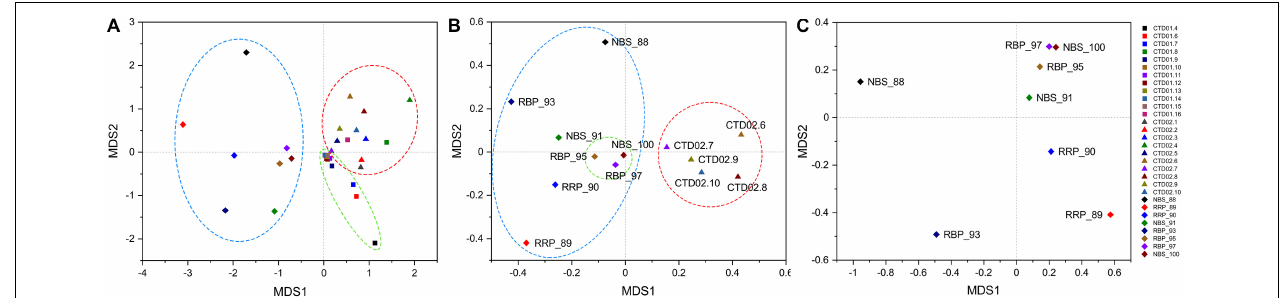
FIGURE 3 | NMDS statistical analysis of bacterial and archaeal communities. (A) Bacterial results from all samples. Diamond: samples collected by HOV Jiaolong. Square: samples of CTD01 station. Triangle: samples of CTD02 water column including three non-buoyant plumes. (B) Bacterial results of those samples consisting of near-bottom seawater and rising buoyant plumes collected by HOV Jiaolong and of non-buoyant plumes and their surrounding seawater. (C) Archaeal results of samples collected by HOV Jiaolong from near vents and the